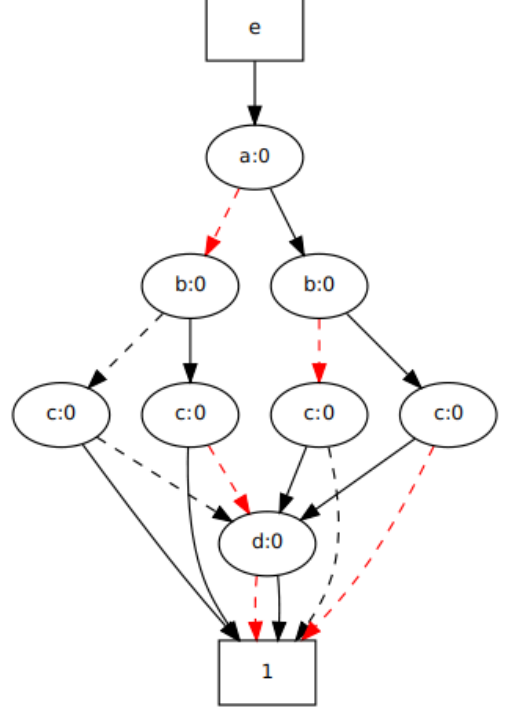
Figure 10. BDD of Benchmark